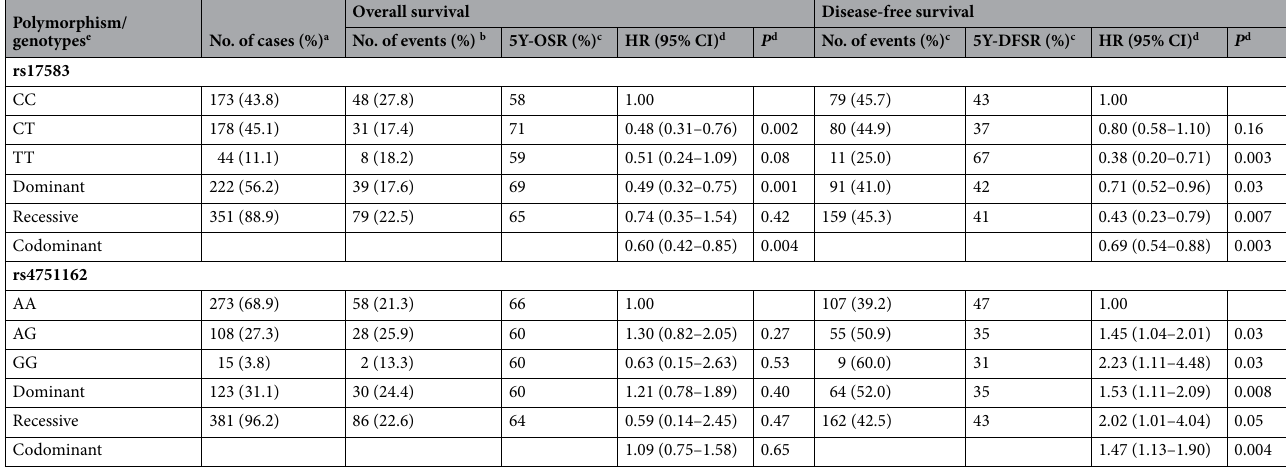
Table 2. Overall and disease-free survival according to genotypes of two polymorphisms in the combined cohorts. a Column percentage. b Row percentage. c Five year-overall survival rate (5Y-OSR) and 5 year-disease free survival rate (5Y-DFSR), proportion of survival derived from Kaplan–Meier analysis. d Hazard ratios (HRs), 95% confidence intervals (CIs) and corresponding P -values were calculated using multivariate Cox proportional hazard models, adjusted for age, gender, smoking status, pathologic stage and adjuvant therapy. e Genotype failure: nine cases for the rs17583 and eight cases for the rs4751162.